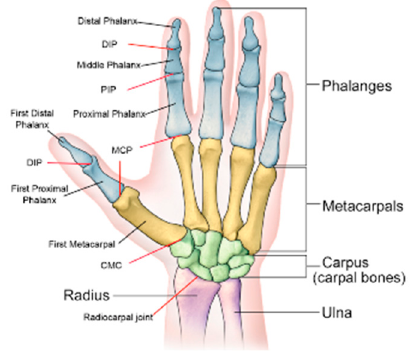
Figure 1. The hand skeleton seen from the palmar side. Originally published in [17]. DIP: distal interphalangeal; PIP: proximal interphalangeal; MCP: Metacarpophalangeal; CMC: Carpometacarpal.